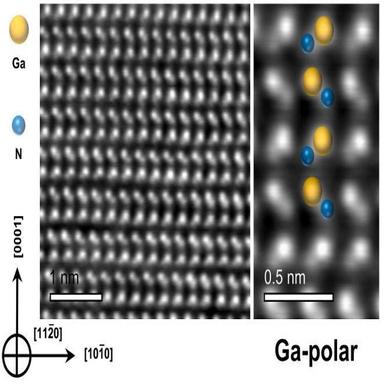
iDPC-STEM image of a single crystalline GaN nanowire along the zone axis. Beam current was maintained below 30 pA, the dwell time is 5 μs, beam convergence angle is 21.4 mrad and the field of view is 12.6 nm. The resulting range of collection angles for the annular DF detector (DF4) is 15–57 mrad, with DPC and scan rotations of 8◦ and − 3◦, respectively. Note that the image is shown as it appears live on the screen without any post-processing. The image reveals the larger Ga atoms on top of the double atom